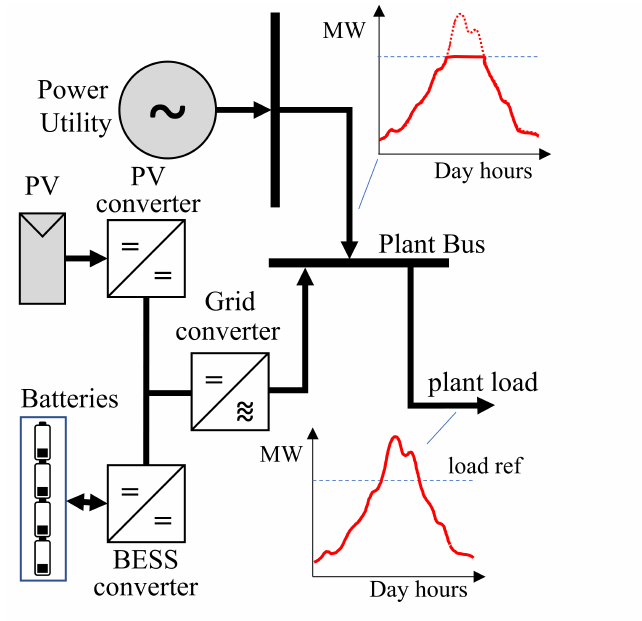
Figure 1. BESS-based peak load shaving